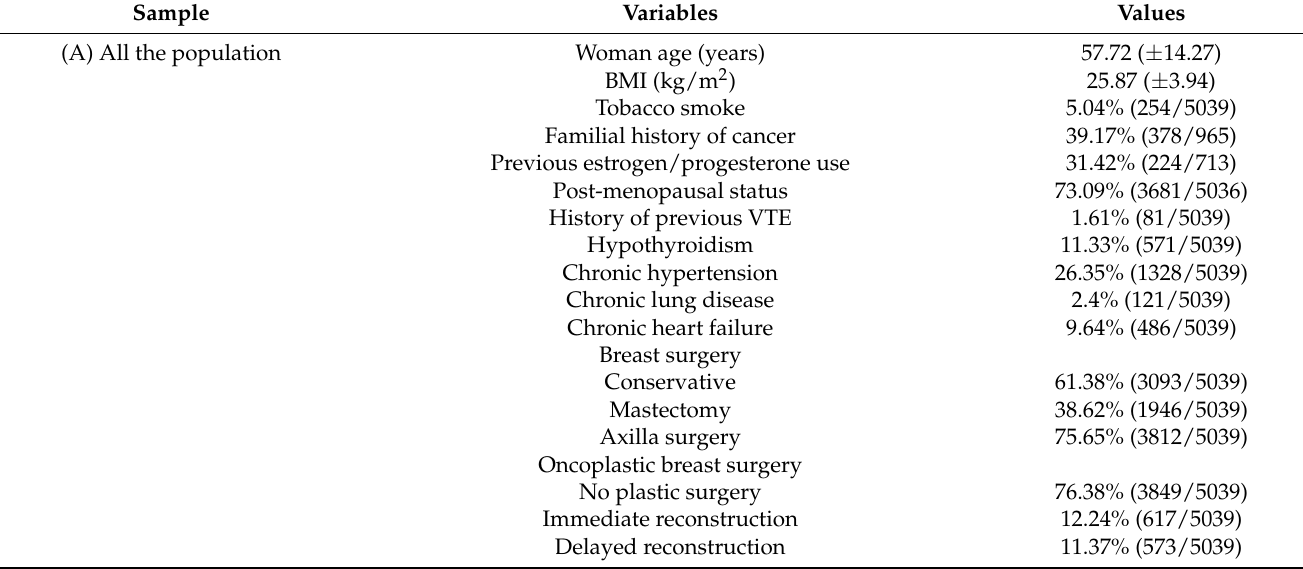
Table 1. Population characteristics: (A) considering the whole cohort of women treated with breast surgery; and (B) considering only breast invasive